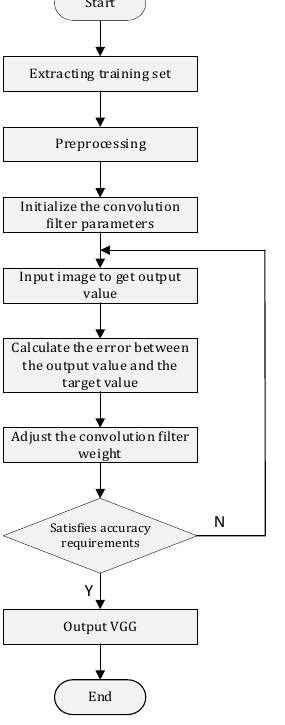
Figure 6. VGG training process.